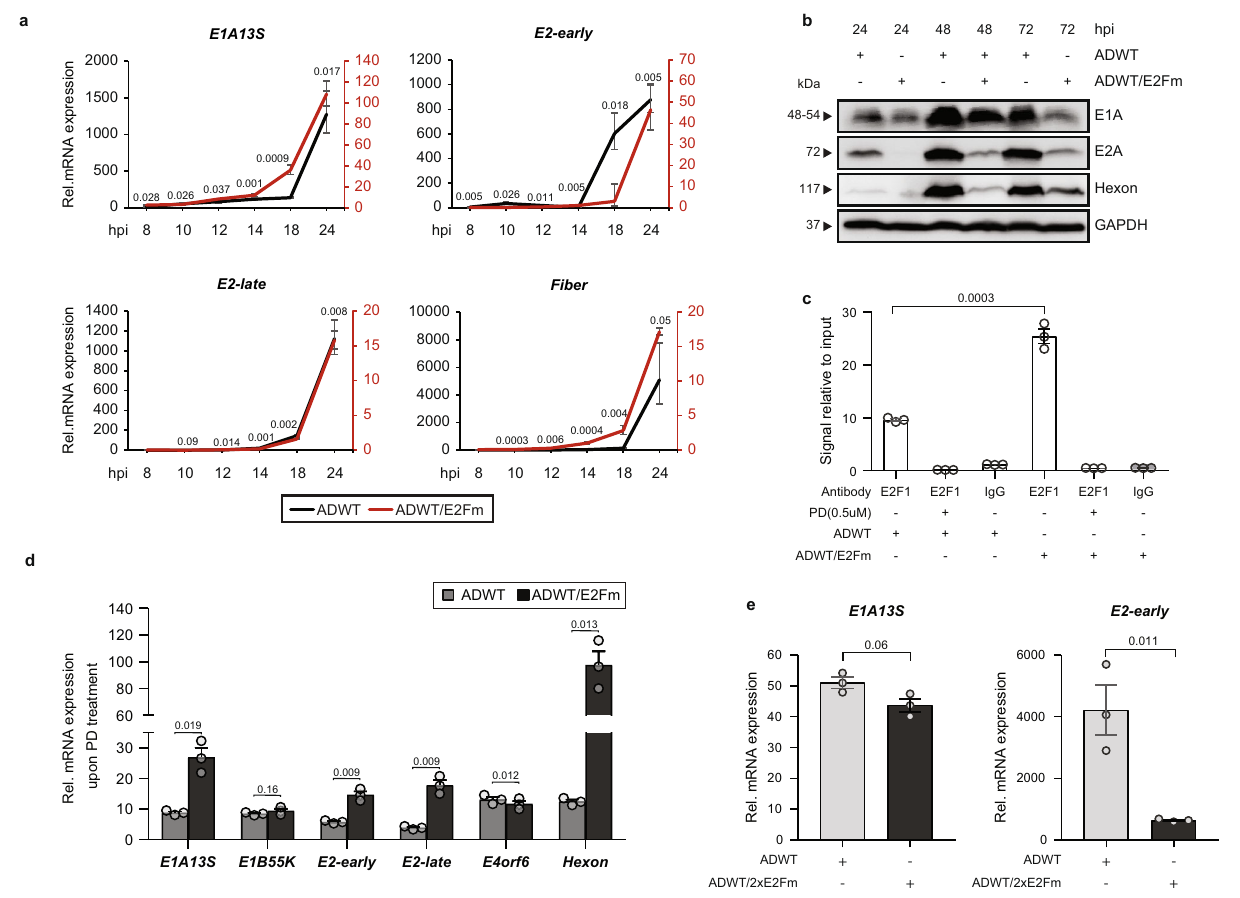
Fig. 7 | CDK4/6i enhances expression of early genes in ADWT/E2Fm. a Gene expression was studied in T24 cells infected with viruses ADWT or ADWT/E2Fm (MOI 10) at indicated time points after infection for the viral E1A13S gene, E2-early transcripts, E2-late transcripts and fi ber gene. Data are represented as relative mRNA expression compared to the reference gene beta-actin ( n =3, mean±SD). b Protein expression was analyzed by western blotting in T24 cells infected with ADWT andADWT/E2Fm(MOI 10)atindicated timepoints. One representative blot is shown of three independent experiments. c T24 cells, infected with ADWT or ADWT/E2Fm (MOI 50), were crosslinked, isolated and DNA was digested with micrococcal nuclease and subjected to chromatin immunoprecipitation using an E2F1 antibody at 8hpi. IgG was used as a negative control. Precipitated DNA was quanti fi ed by RT-PCR using primers for the E1-enhancer. Palbociclib (0.5 µ M)